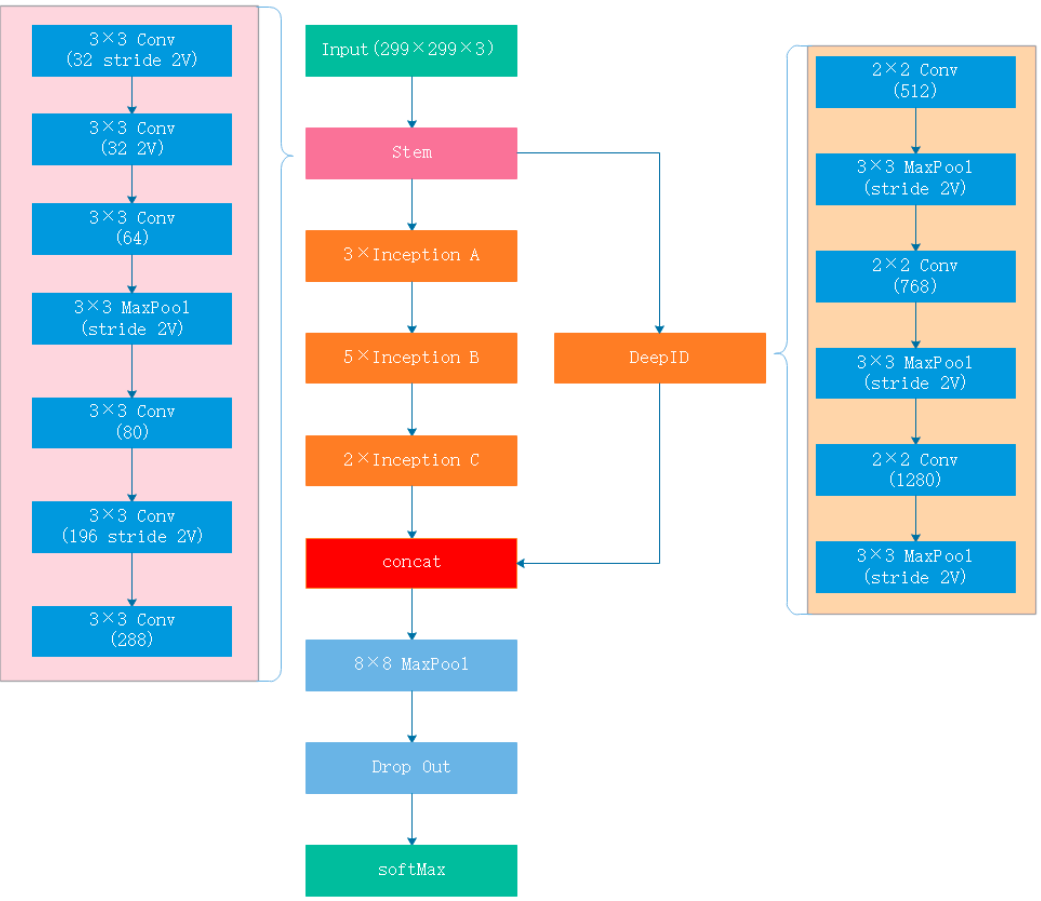
Figure 3. Inception-DeepID-FNP CNN.